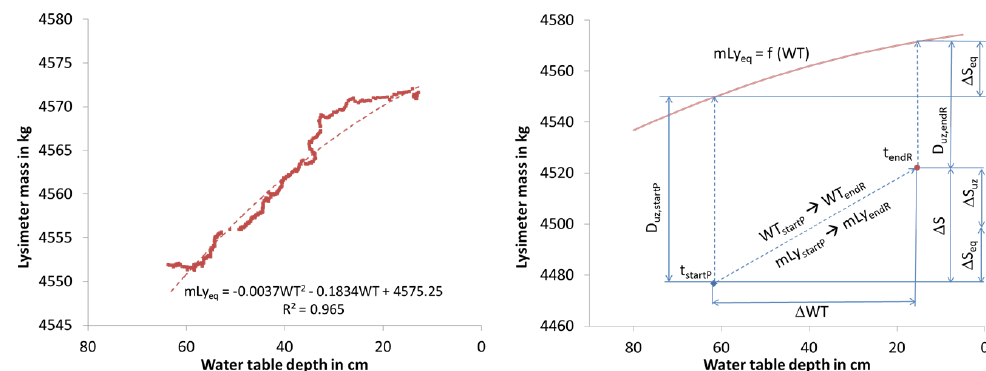
Figure 3. Hourly values of lysimeter mass corrected by precipitation and evapotranspiration (mLy corr ) and water table (WT) for the selected drainage period in March 2012, regression curve representing the shape of the lysimeter’s water storage characteristic under quasi-equilibrium conditions (S eq ) ( left ). Illustration of the calculation of di ff erent storage shares for a single precipitation event depending on the measured mLy and WT as well as calculated ∆ S eq under quasi-equilibrium conditions (Equations (5) and (6)) at the times t startP and t endR ( right , ∆ WT—change in water table, ∆ S—measured water storage change, ∆ S eq —calculated water storage change under quasi-equilibrium conditions, ∆ S uz —replenishment of unsaturated zone without WT change, D uz —soil moisture depletion in the unsaturated zone, mLy eq is based on the regression curve of the left